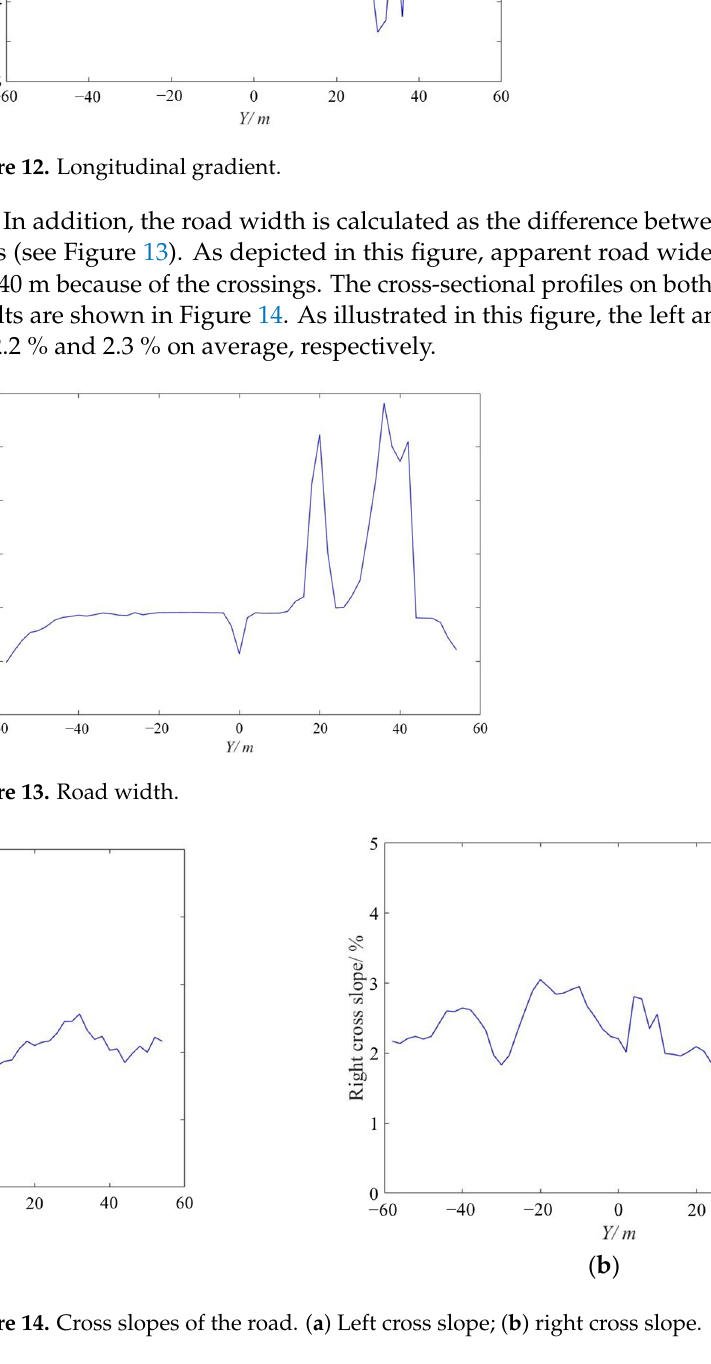
16 of 23 Figure 10. Generated original centerline.